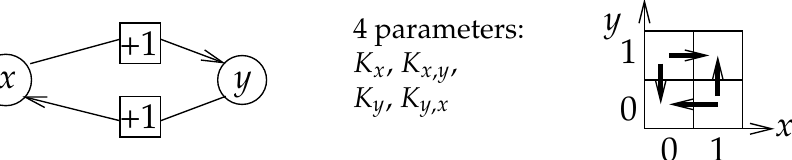
Figure 1. Toy example. Left: an influence graph made of a positive loop (+ , +) . Center: the parameters